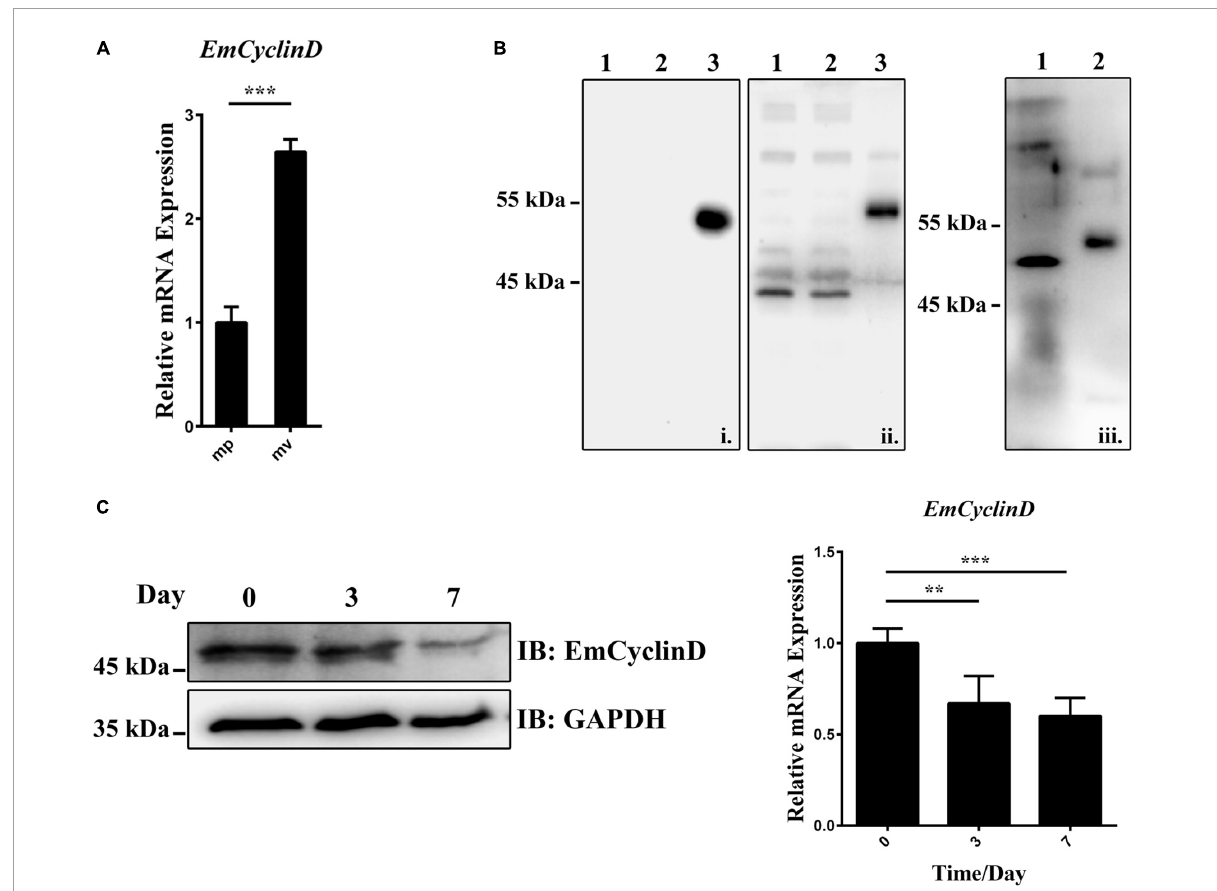
FIGURE3 Expression of EmCyclinD in E. multilocularis germinative cells. (A) Relative mRNA levels of EmCyclinD in the mature protoscoleces (mp) and metacestode vesicles (mv). (B) Lysates of bacteria expressing His-tagged EmCyclinD were analyzed by western blotting using the anti-His tag antibody (i) or the anti-EmCyclinD antibody (ii). Line 1 and 4: empty vector control; line 2 and 5: IPTG uninduced; line 3 and 6: IPTG induced. Total protein of in vitro -cultured vesicles (iii, line 7) was analyzed with the anti-EmCyclinD antibody. His-tagged recombinant EmCyclinD was used as a control (iii, line 8). (C) mRNA and protein expressions of EmCyclinD in the metacestode vesicles treated with 40 mM of hydroxyurea for 3 or 7 days. Data in (A,C) are shown as mean ± SD . ** P < 0.01, *** P <